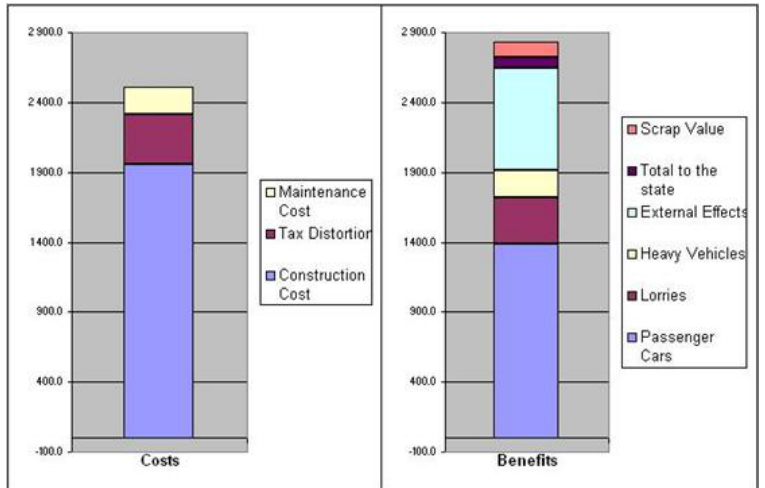
Figure 6. Deterministic run of CBA-DK illustrating a road infrastructure project in the northern part of Zealand, Denmark (Salling and Leleur 2006b)